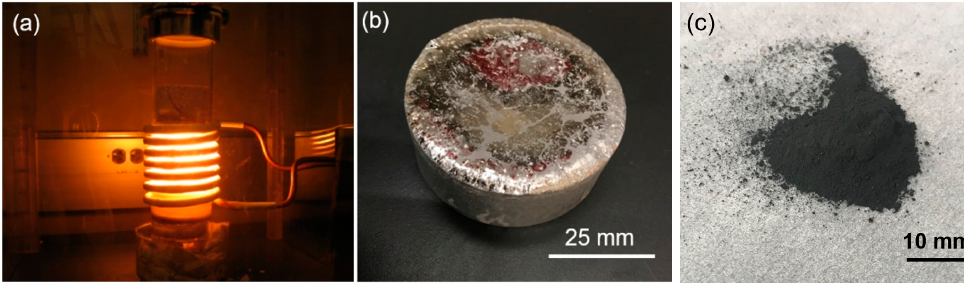
Figure 1. ( a ) Induction melting process, ( b ) a synthesized Bi 2 Te 3 ingot made from induction melting, and ( c ) the uniform powder after ball